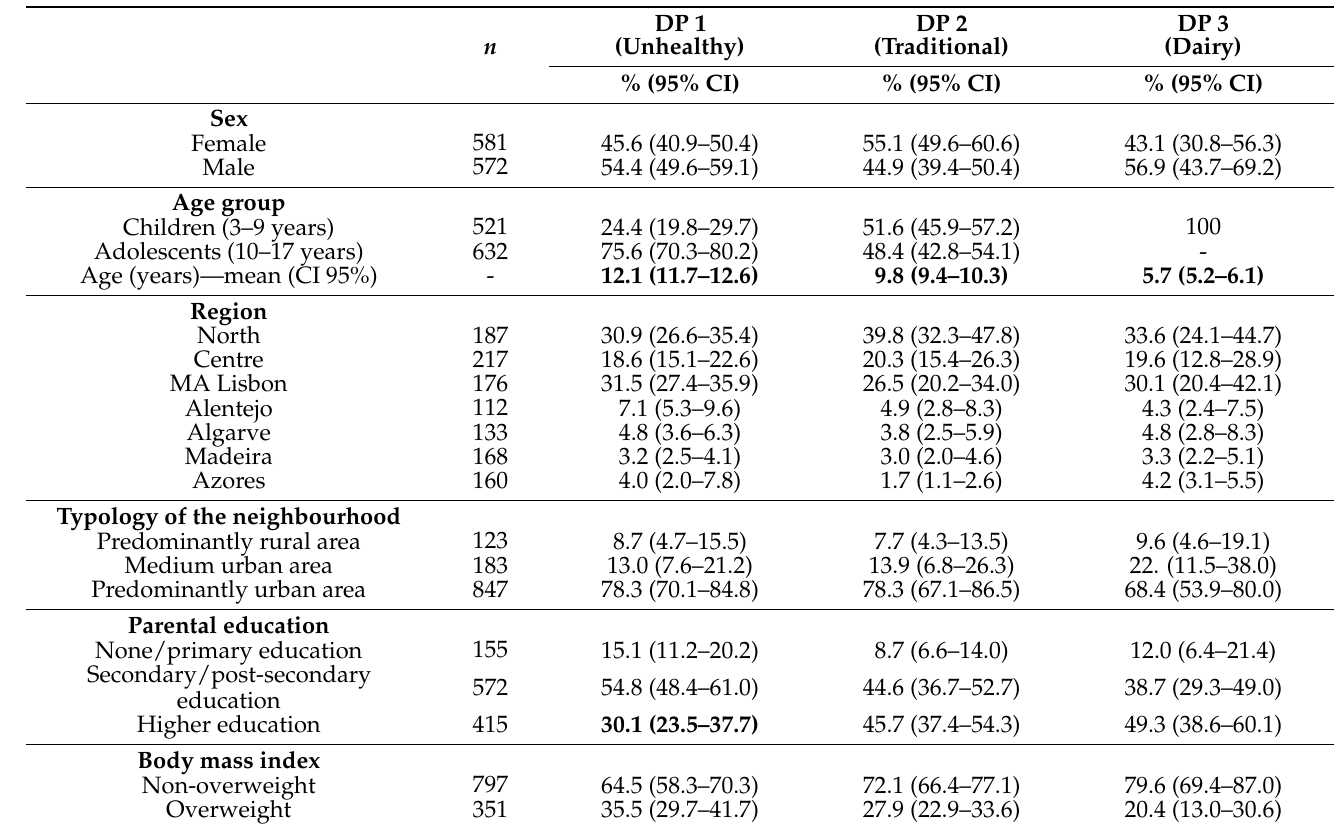
Table 2. Sociodemographic characteristics and BMI according to dietary patterns among Portuguese population aged 3–17: The UPPER project.